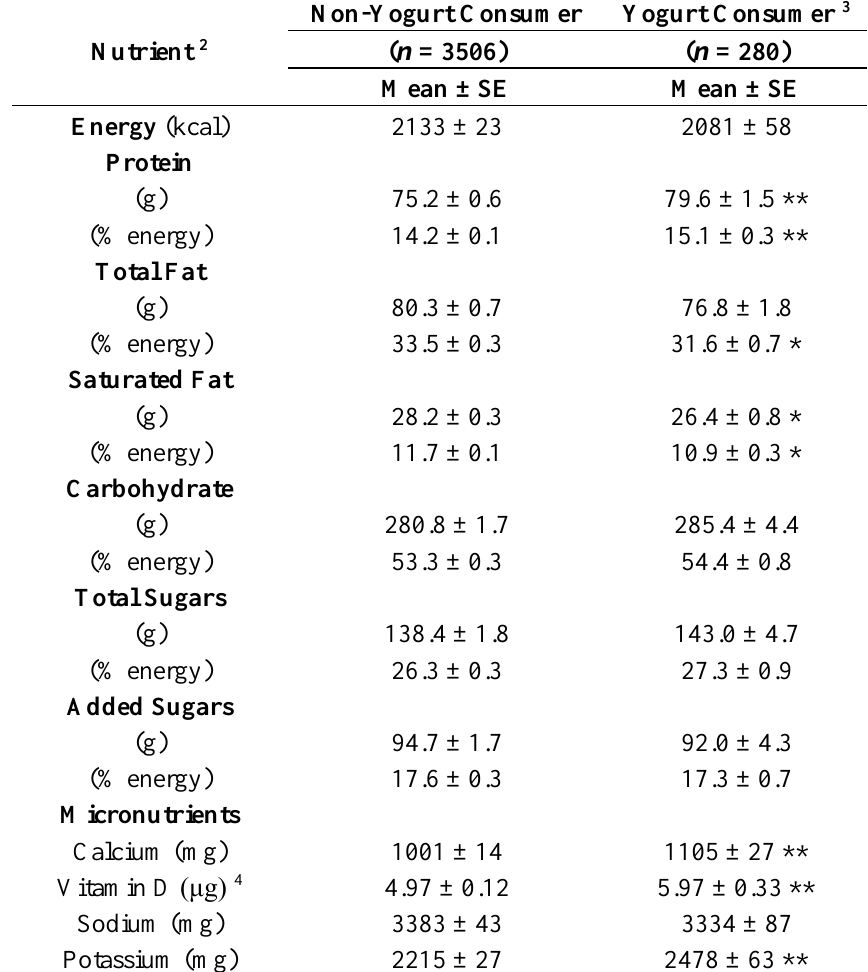
Table 1. Covariate-adjusted mean energy, macronutrient, calcium, vitamin D, sodium, and potassium intake by yogurt consumption groups 1